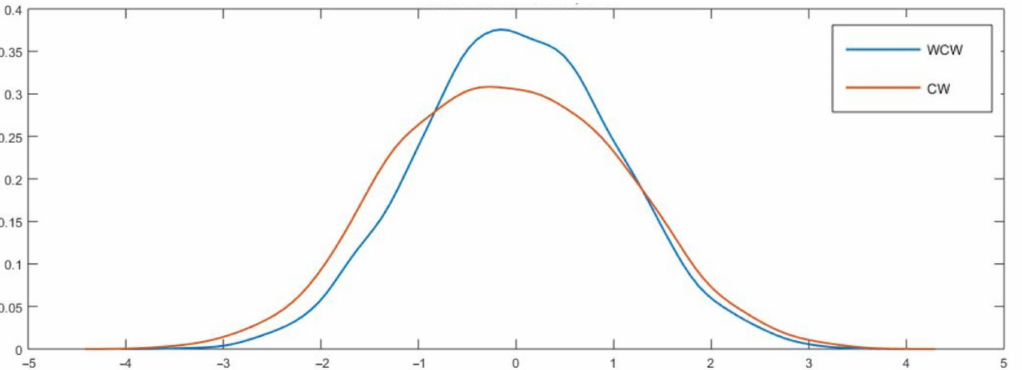
Figure 1. Kernel densities of CW and WCW under the null hypothesis, DGP2, h = 12. Notes: For this exercise, we considered large samples (P = R = 450 and T = 900) and 4000 Monte Carlo simulations. We evaluated CW and our test computing iterated forecasts. In this case, we used WCW with K = 1 and σ ( θ t ) = 0.04 ∗ σ ( ˆe 2 ) .